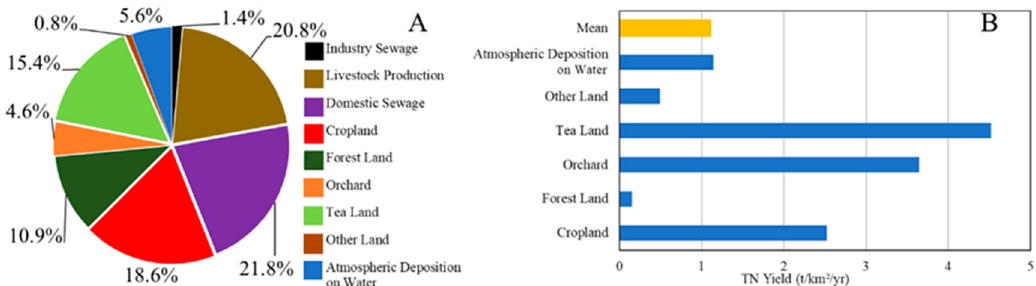
Figure 5. ( A ) Simulated annual contributions of point and non-point sources of pollution to TN loads, as expressed as percentages of the total. ( B ) Simulated annual contributions of non-point sources of pollution, expressed on a per unit area basis, i.e., as TN yields. The yellow bar gives the mean for all land use types.